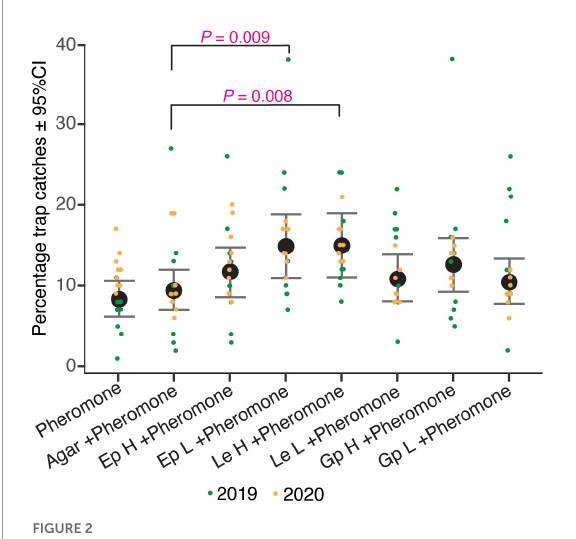
FIGURE2 Percentage trap catches of I. typographus in pheromone traps baited with various loads of different fungal cultures. pheromone: I. typographus pheromone consists of 2-methyl-3-buten-2-ol and cis -verbenol with a release rate of 42 and 1.5 mg/day, respectively; agar, perforated Petri dish (90 mm in diameter) containing only potato dextrose agar (PDA); Ep, Endoconidiophora polonica ; Le, Leptographium europhioides ; Gp, Grosmannia penicillata grown on PDA for 4–7 days; H, high load of fungus culture (three Petri dishes); L, low load of fungus culture (one Petri dish). Whiskers represent 95% confidence intervals (CI), black dots are the predicted mean of combined year percentage trap catches generated by the linear mixed model and colored dots are original values from different